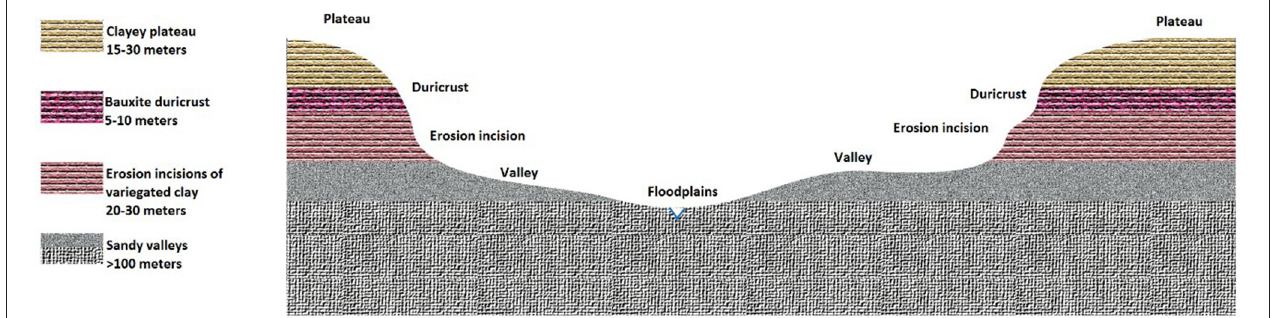
FIGURE 1 | Geological profile and pedo-morphological units in Paragominas in the northeast state of Pará, Brazil.